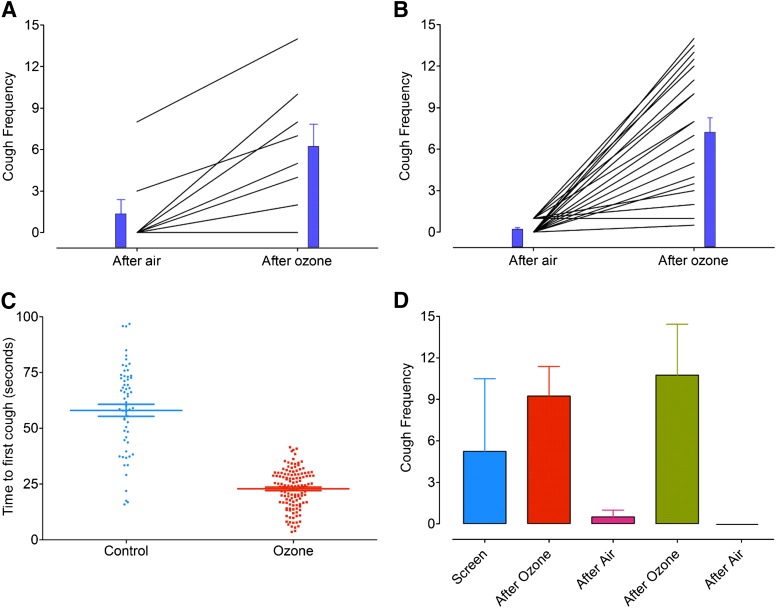
Frequency of cough in response to 0.4 M citric acid (A) and 0.8 M citric acid (B) following exposure to air or ozone (2 ppm, 1-hour exposure) in rabbits. The time period between each group, after air or after ozone, was 7 days, and the sequence of whether a rabbit received ozone or air first was randomized. The blue bars indicate the mean response after air and after ozone, and the error bars represent the S.E.M. (N = 8 and 25, respectively). (C) Time-to-first-cough rabbits, defined as the time in seconds when the first cough occurred after the nebulizer containing citric acid was turned on. The thick horizontal bar represents the mean and the error bars are the S.E.M., N = 48 for the rabbit controls and N = 129 for the ozone-sensitized rabbits. (D) The effect of a repeated challenge with ozone on cough response was measured in a small cohort of rabbits (N = 4). Rabbits were challenged with citric acid on day 0, then exposed to either ozone or air on day 7. Rabbits were then crossed over to treatment on day 14, and this crossover by exposure was repeated on days 21 and 28. Column represents the mean and vertical lines represent S.E.M.